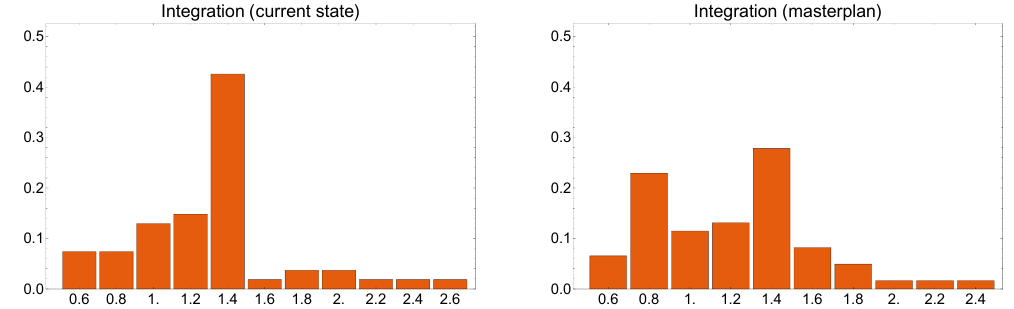
Figure 11. The distribution of Integration of the central archaeological area, as in the current situation (left) and in the project (right).